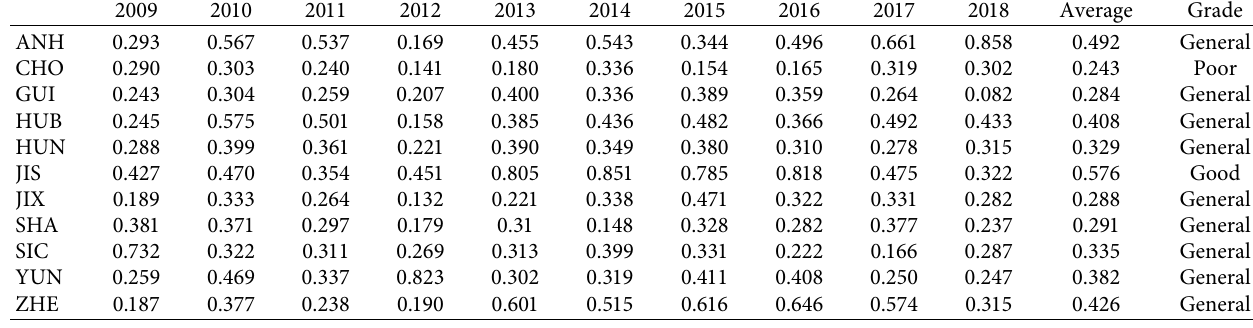
Table 5: CDD of air environment.